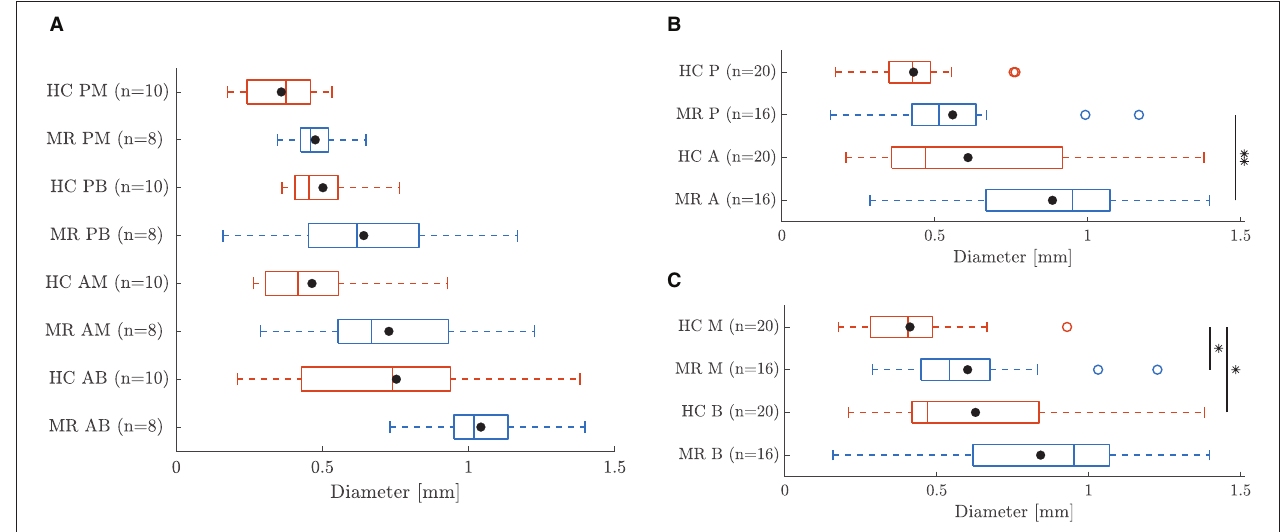
FIGURE 5 | (A) Experimental and model stress-stretch curves of leaflet sample HC 9 AL with a NRMSE of 0.50. (B) Experimental and model stress-stretch curves of chord sample MR 9 AM with a NRMSE of 0.21 .